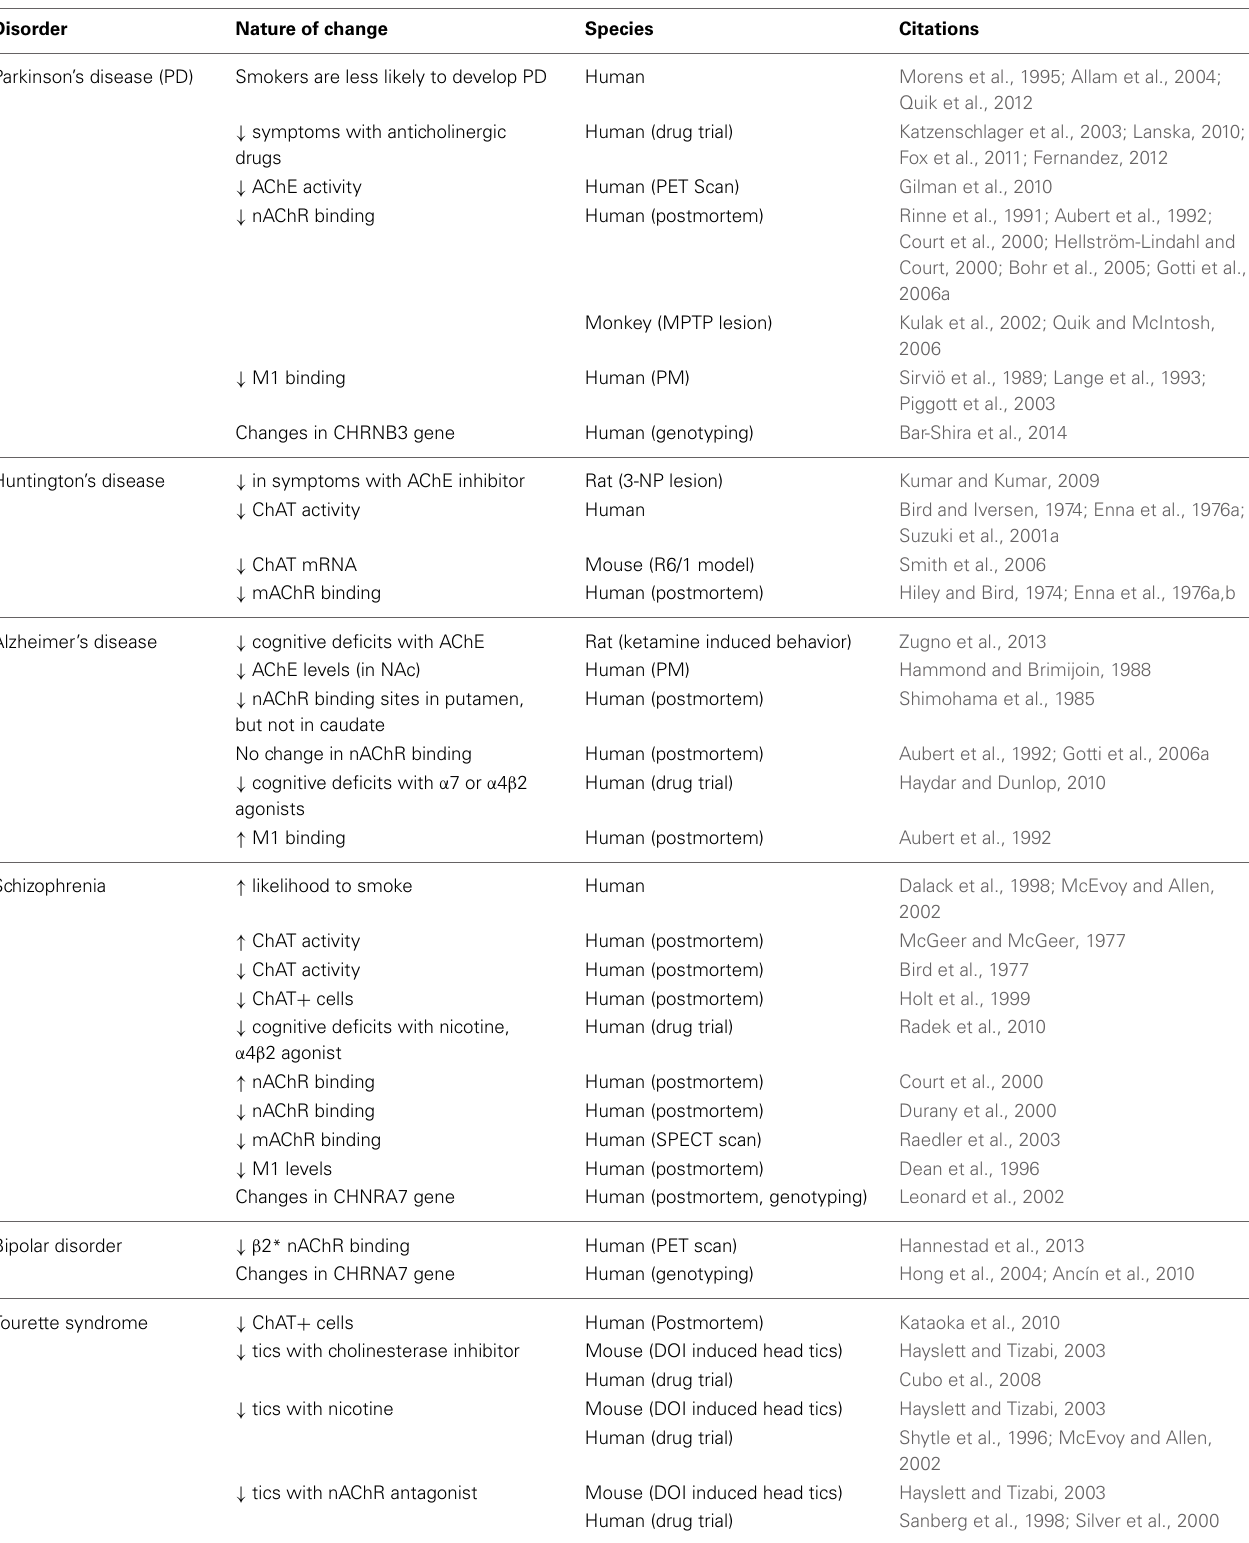
Table 1 | Diseases associated with striatal cholinergic